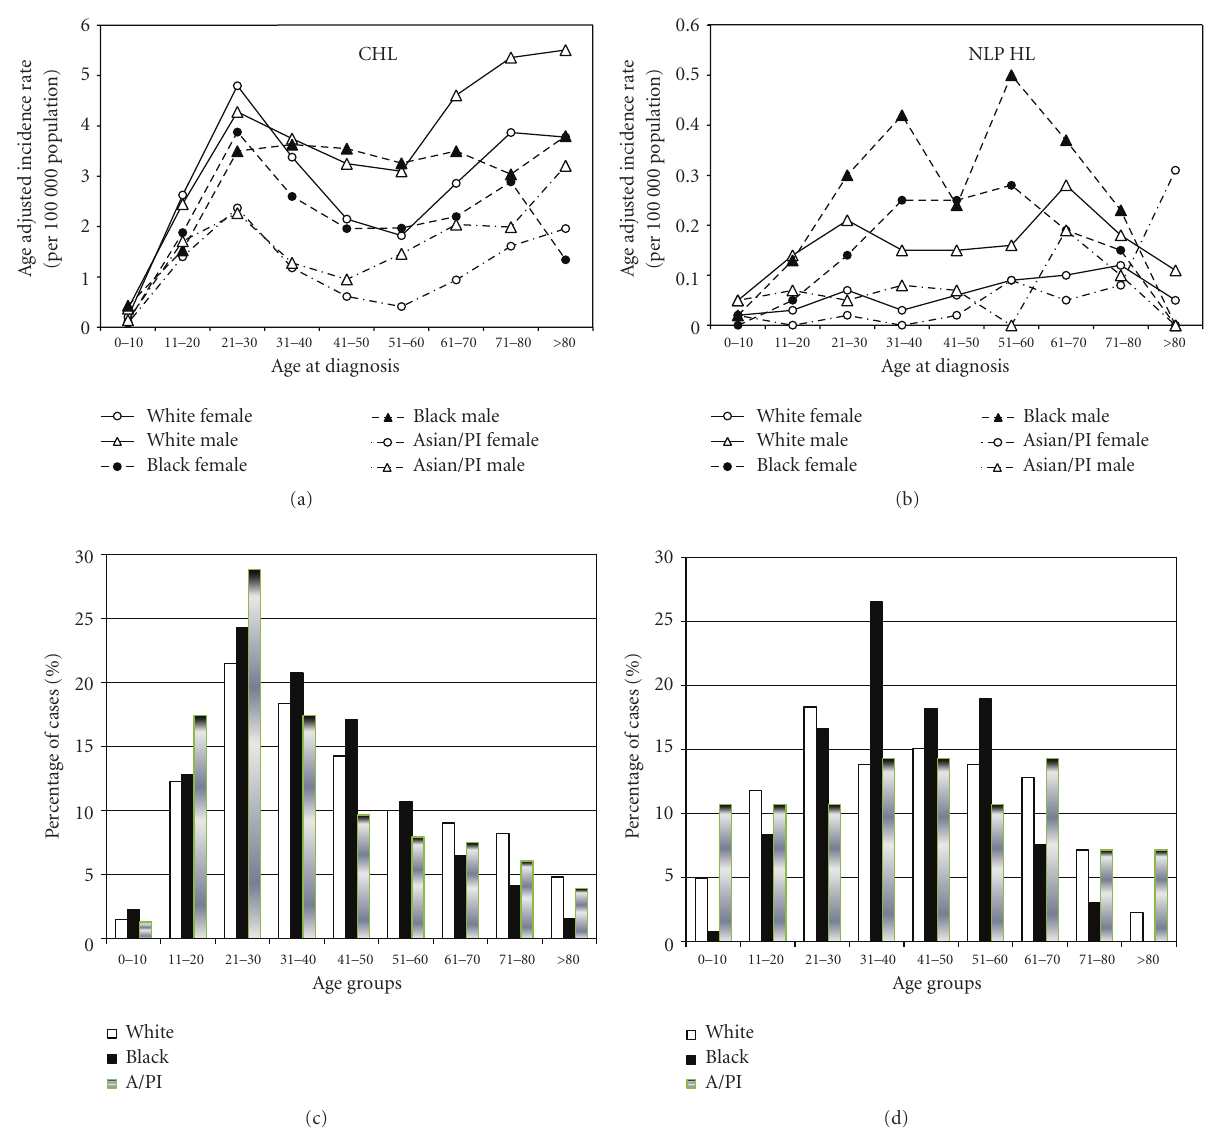
Figure 2: Age distribution of HL by race. (a) Plots are the race- and gender-specific age-adjusted incidence rates of CHL by age at diagnosis. (b) Plots are the race- and gender-specific age-adjusted incidence rates of NLP HL by age at diagnosis. (c) Plots are the age distribution of CHL patients. Horizontal axis represents the grouping of age at diagnosis. Vertical axis represents the proportion of patients in each age group for that particular race (White, Black, and Asian/Pacific Islander). (d) Plots are the age distribution of NLP HL patients. Horizontal axis represents the grouping of age at diagnosis. Vertical axis represents the proportion of patients in each age group for that particular race (White, Black, and Asian/Pacific